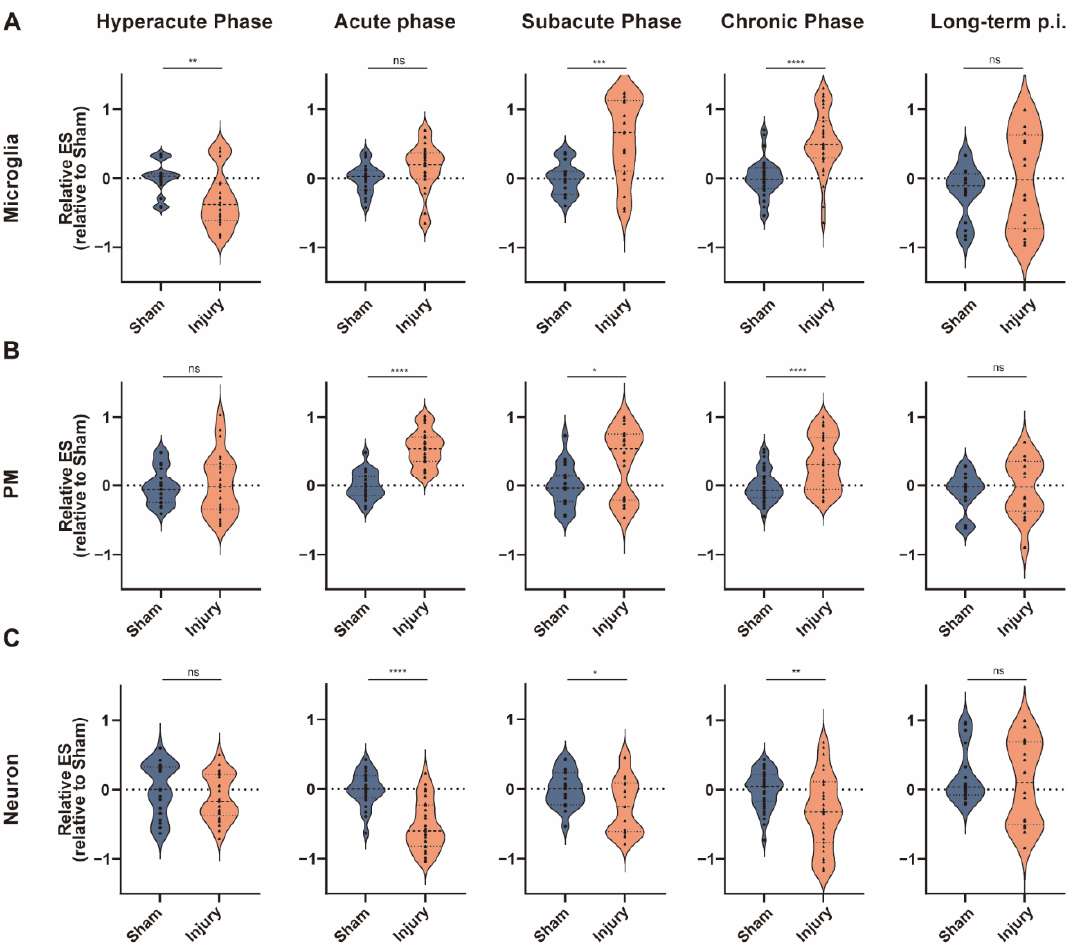
Figure 8. Analysis of cellular abundance of microglia, PM, and neurons during various courses of TBI. Violin plots showing aggregated GSVA enrichment scores for microglia ( A ), PM ( B ), and neurons ( C ) in hyperacute, acute, subacute, and chronic phases of TBI. For hyperacute phase, N = 27 for Sham group and N = 25 for Injury group; for acute phase, N = 23 for Sham group and N = 27 for Injury group; for subacute phase, N = 19 for Sham group and N = 20 for Injury group; for chronic phase, N = 35 for each group; for long-term p.i., N = 16 for each group. **** p < 0.0001, *** p < 0.001, ** p < 0.01, * p < 0.05. Data are shown as means ± SEM.